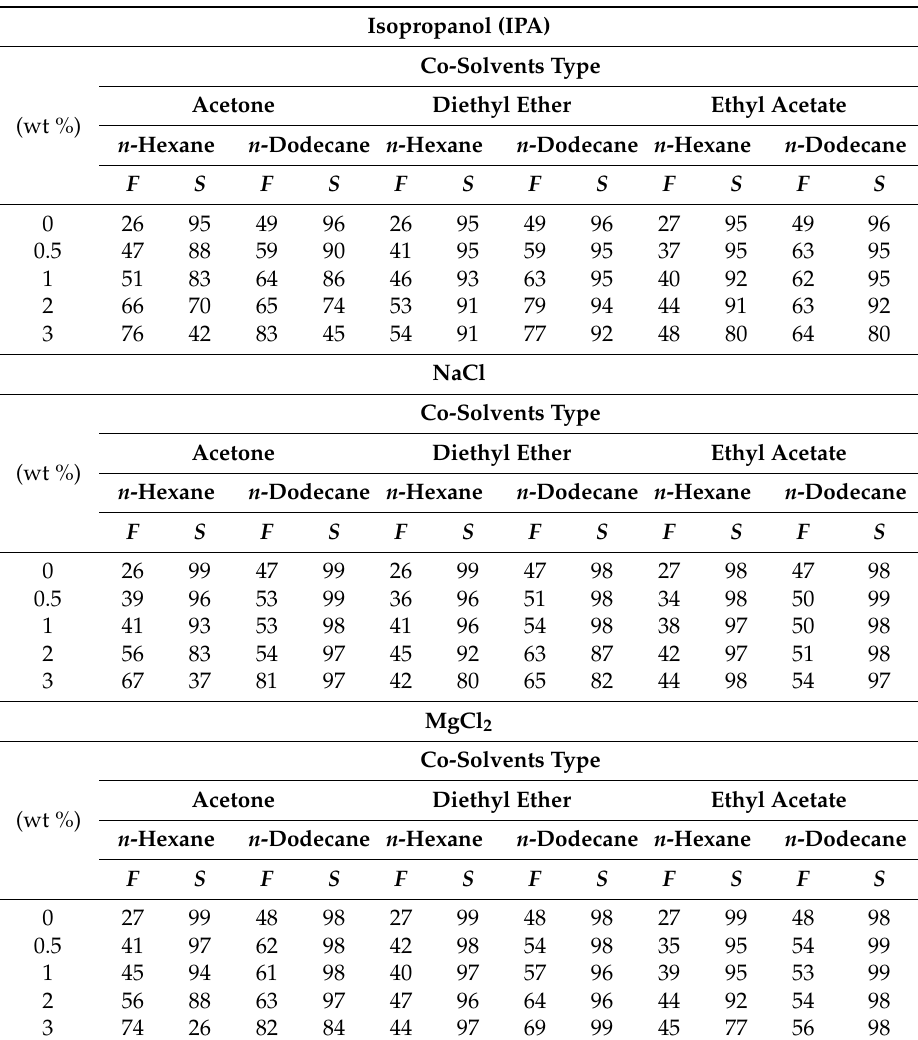
Figure 8. Flux of NaCl through membranes formulated with acetone, diethyl ether and ethyl acetate added as co-solvents. Table 1. A comparison between the performance of hexane and dodecane based membranes. Data for hexane are obtained from Al-Hobaib et al. [41].